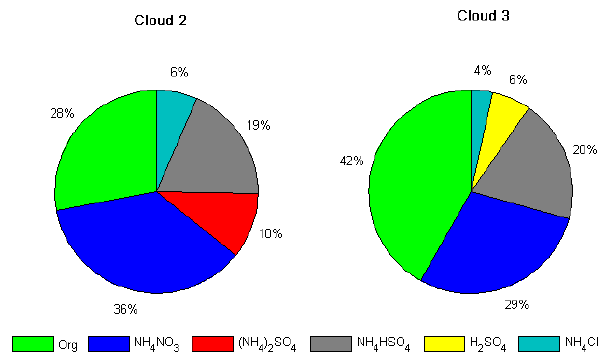
Figure 7. Sub-micrometer non-refractory average aerosol mass fractions for Clouds 2 and 3 based on an ion-pairing scheme (see text and Sect. S5) and measured from a high resolution time-of- flight aerosol mass spectrometer.